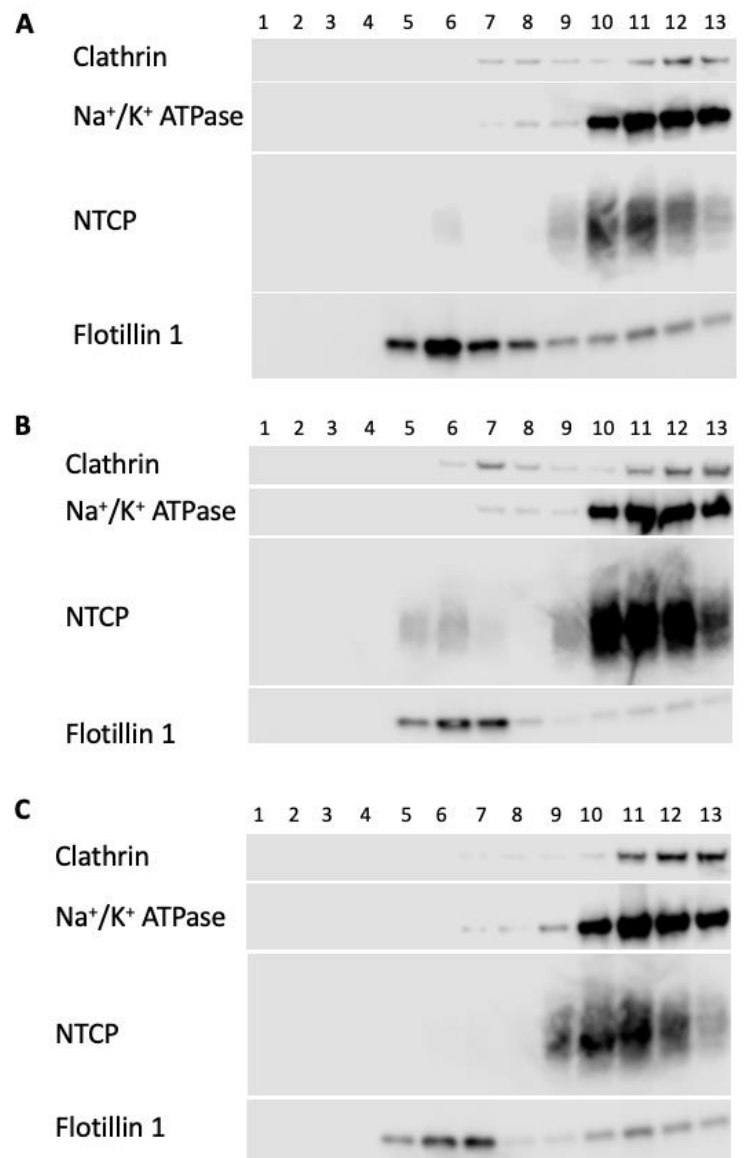
Figure 9. Distribution of marker proteins in lipid rafts isolated from NTCP-expressing HEK293 cells. NTCP-expressing HEK293 cells were treated with ( A ) Opti-MEM (control), ( B ) 0.8 mM cholesterol, or ( C ) 5 mM MCD, after which they were homogenized, centrifugated, and fractionated as outlined in the Materials and Methods section. Aliquots of the 1 mL gradient fractions were analyzed using western blotting. Positive lipid raft markers are caveolin and flotillin-1; negative markers are clathrin and Na + /K + ATPase.